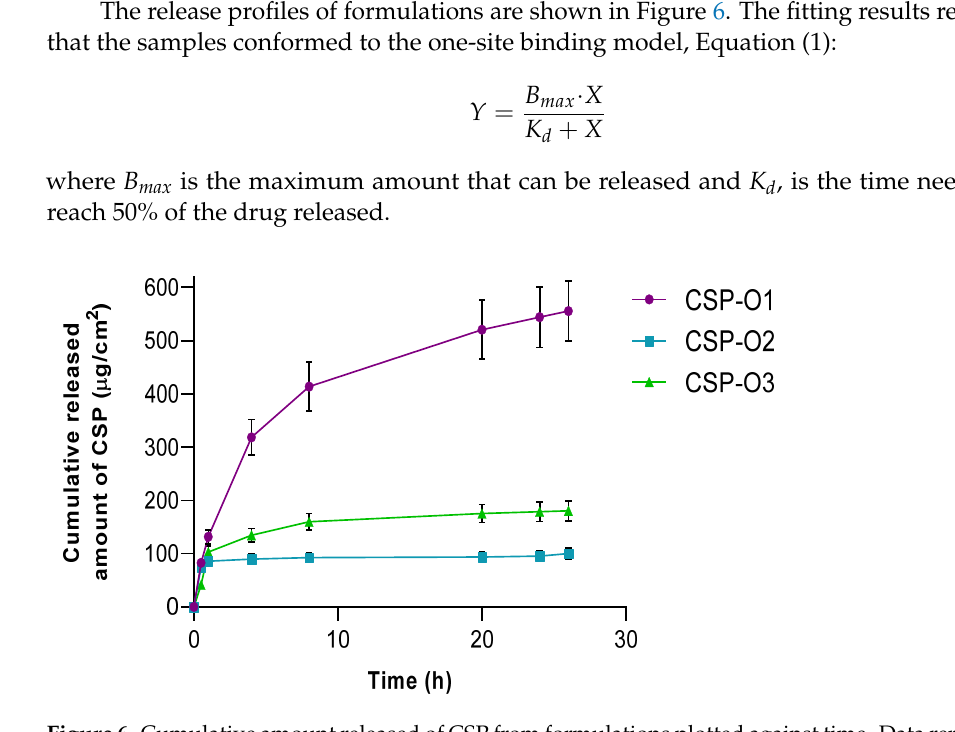
Figure 6. Cumulative amount released of CSP from formulations plotted against time. Data represents mean ± SD ( n = 5).